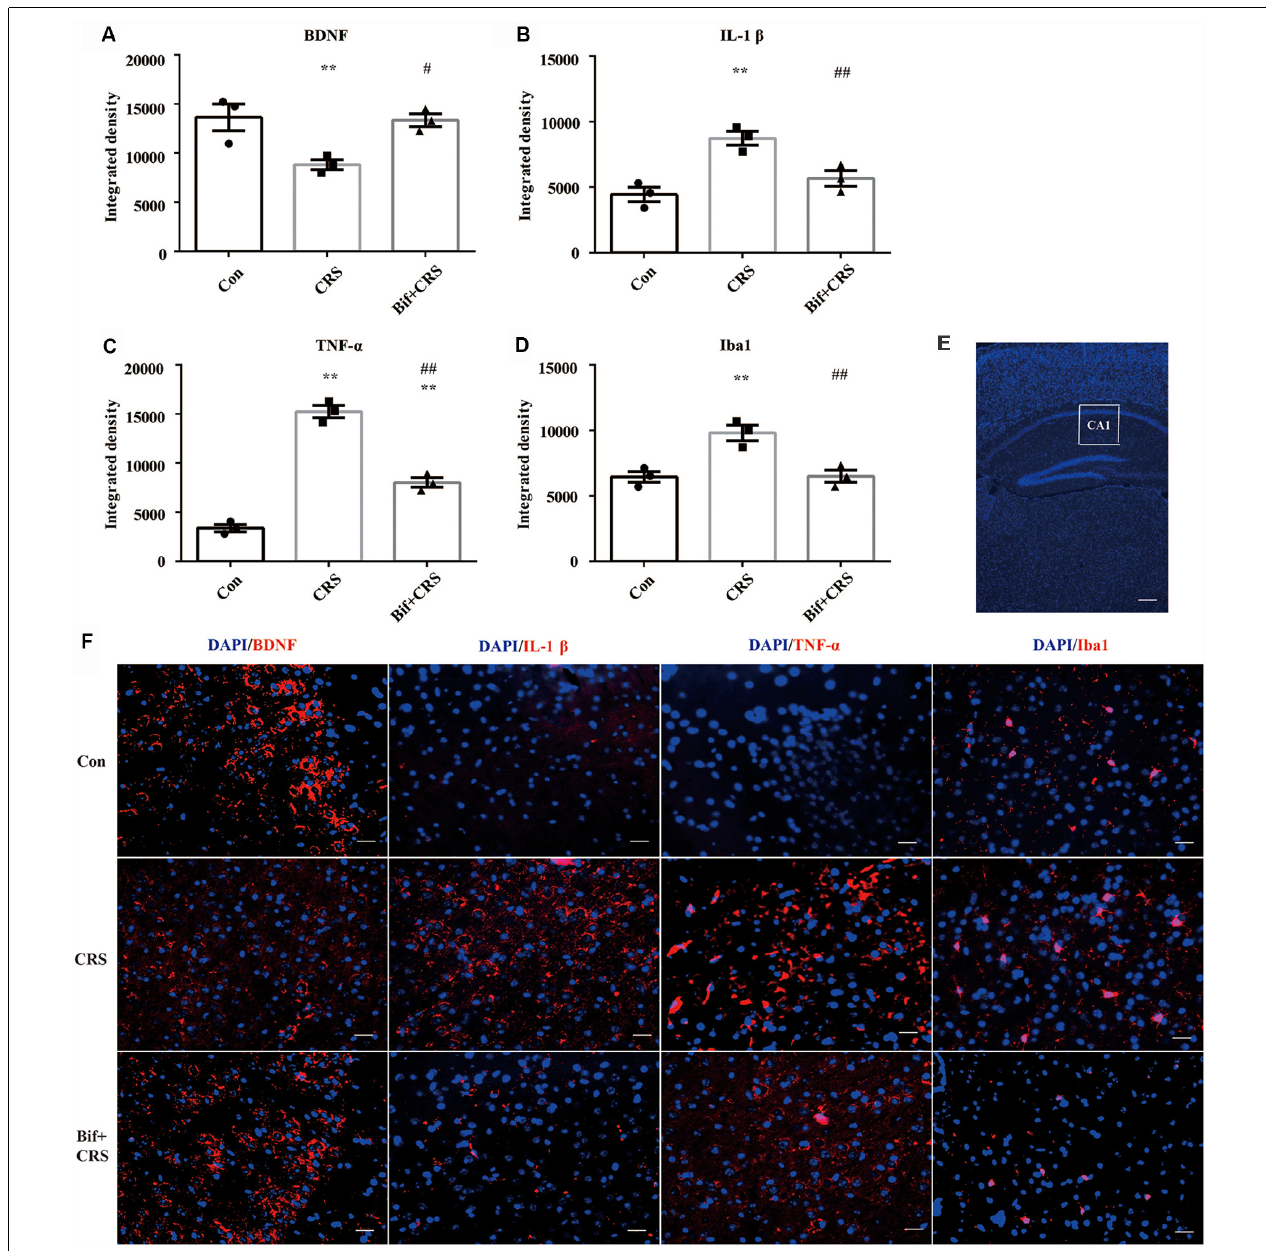
FIGURE 6 | Changes in the protein expression of BDNF, IL-1 β , TNF- α , and Iba1 in the CA1 region of the hippocampus induced by pretreatment with B. adolescentis . Immunofluorescence analysis showed that (A) the protein level of BDNF was upregulated by B. adolescentis , and the protein levels of (B) IL-1 β , (C) TNF- α , and (D) Iba1 in the CA1 region of the hippocampus were obviously suppressed by B. adolescentis . The data are shown as the mean ± SEM. One-way ANOVA followed by the Student-Newman-Keuls test was used. ∗∗ p < 0.01 vs. the control; # p < 0.05 and ## p < 0.01 vs. the CRS group; n = 3 per group. (E) The CA1 region was identified as shown in the box. Scale bar = 200 µ m. (F) Immunofluorescence was performed and subsequently visualized with Cy3 (red)-labeled secondary antibodies. DAPI (blue) was used as a nuclear stain. Scale bar = 20 µ m. Con, Control; CRS, chronic restraint stress; Bif+CRS, B. adolescentis + chronic restraint stress; BDNF, brain derived neurotrophic factor; IL-1 β , interleukin-1 β ; TNF- α , tumor necrosis factor α ; Iba1, ionized calcium binding adapter molecule